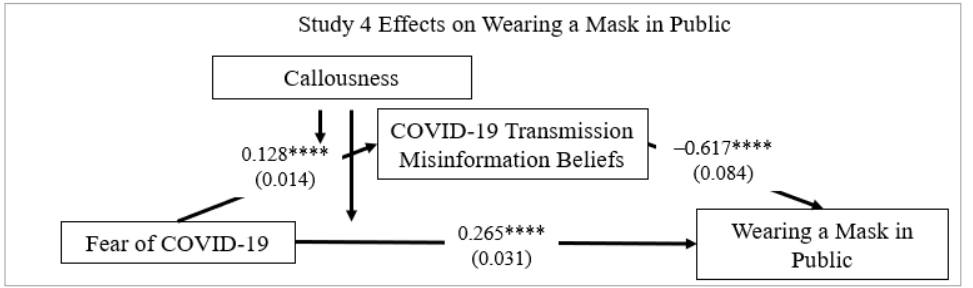
Figure 2. Study 4 effects on wearing a mask in public model estimates. Table 6. Study 4 moderated mediation results of fear of COVID-19 and wearing a mask in public. Outcome